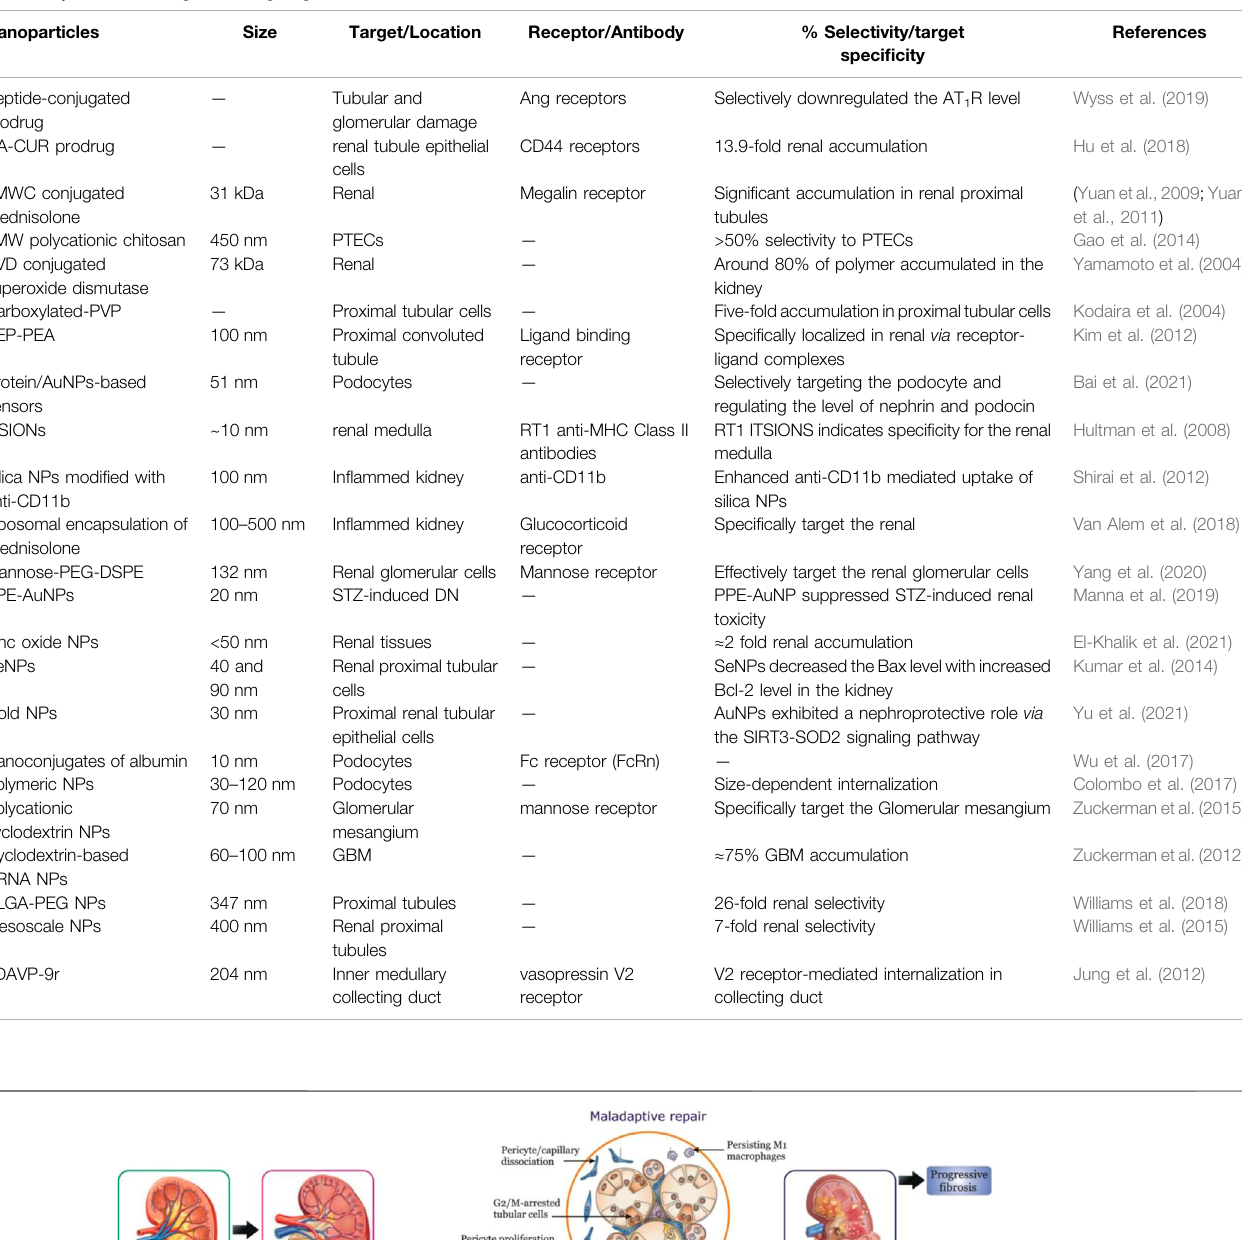
TABLE 1 | Nano-technological for targeting renal diseases and DN.